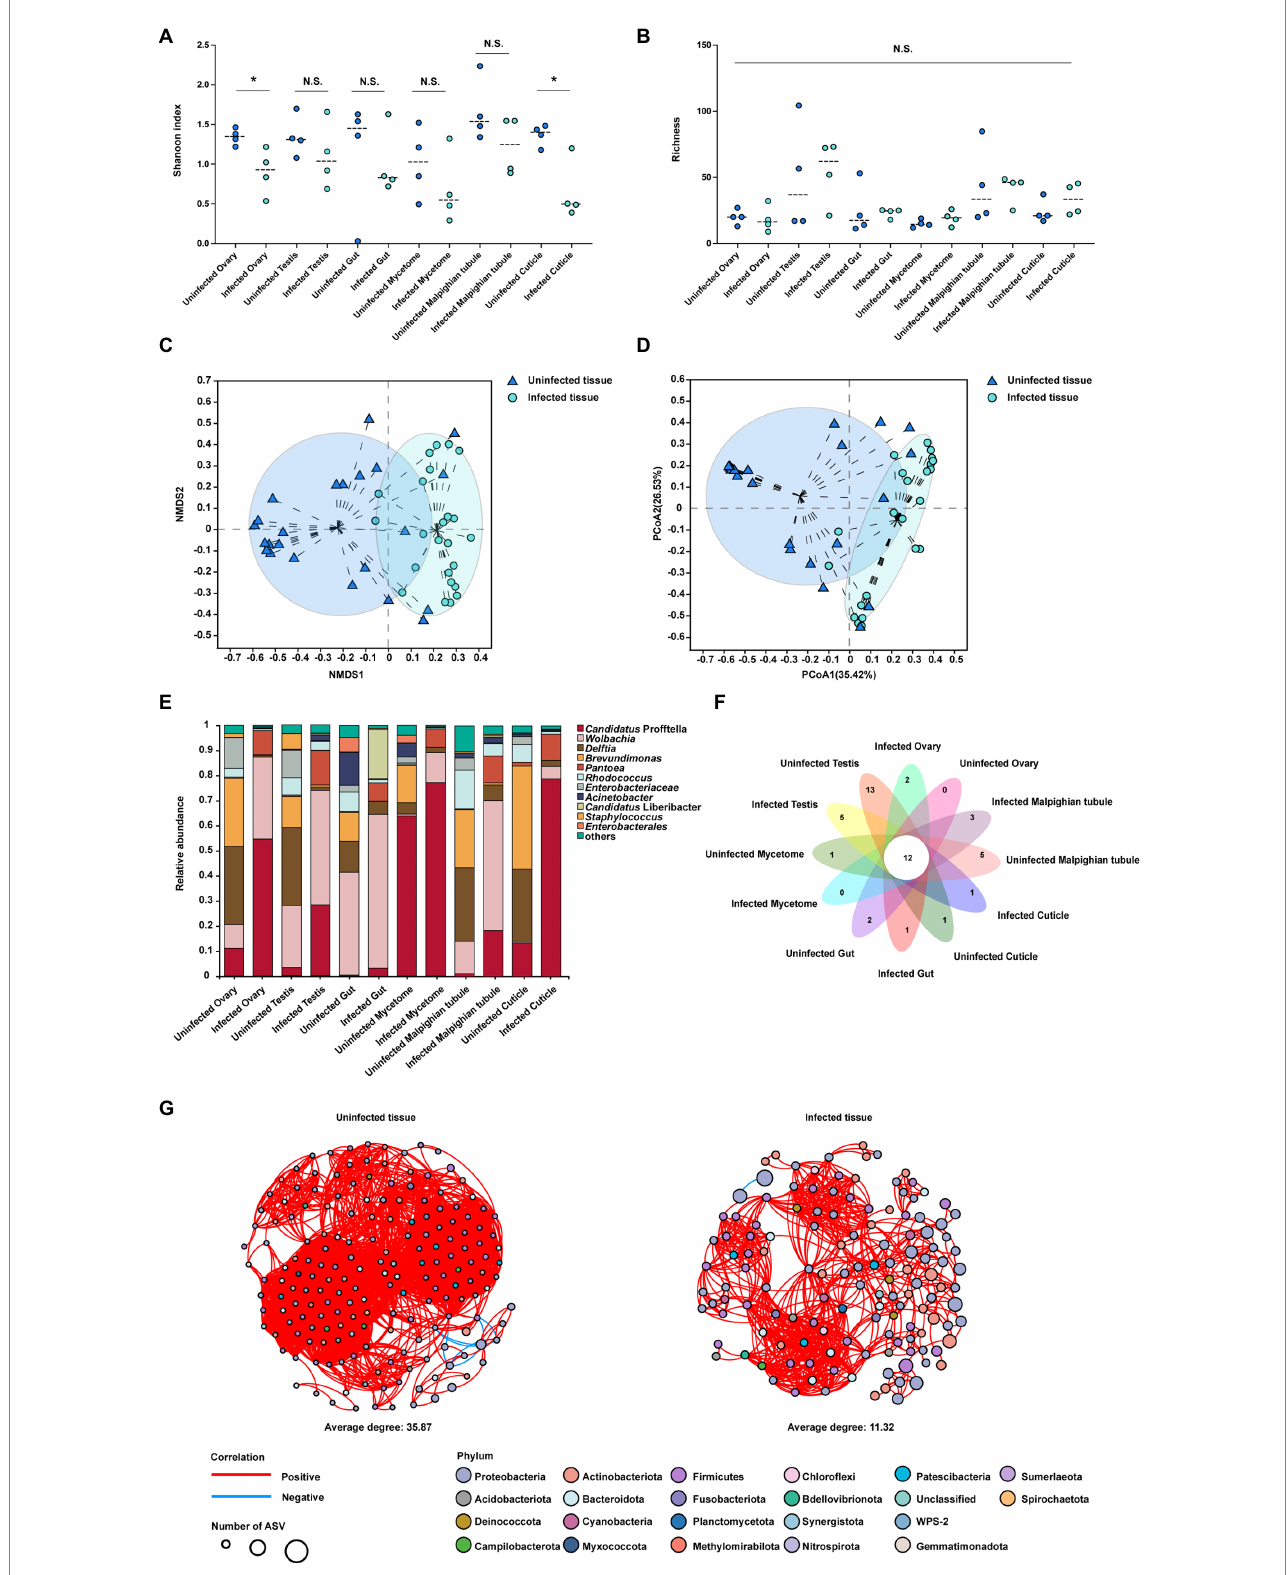
FIGURE 3 The alpha and beta diversity analysis in the tissues of C Las uninfected and infected ACP. (A) Shannon’s diversity index showed bacterial community diversity in different tissues of C Las uninfected and infected ACP. (B) The Chaol index showed bacterial community richness in different tissues of C Las infected ACP. (C) Non-metric multidimensional scaling (NMDS) analysis. (D) Principal components analysis (PCA). (E) The bar plot of the bacterial proportion in the tissues of C Las uninfected and infected ACP. (F) Core-Pan ASV presented the common and unique ASV of all samples in the petal diagram. (G) The bacterial network between different tissues of C Las uninfected and infected ACP. Edges represent significant Spearman correlations ( ρ > |0.6|, p < 0.05). Light blue and red lines represent significant negative and positive correlations, respectively. The size of the points indicates the number of ASVs in each bacterial community. The data were analyzed by the analysis of variance (ANOVA) followed by Tukey’s test, comparisons of Shannon diversity and Chaol index were by non-parametric analysis (*, p < 0.05; p > 0.05 means no significant difference. N.S., no